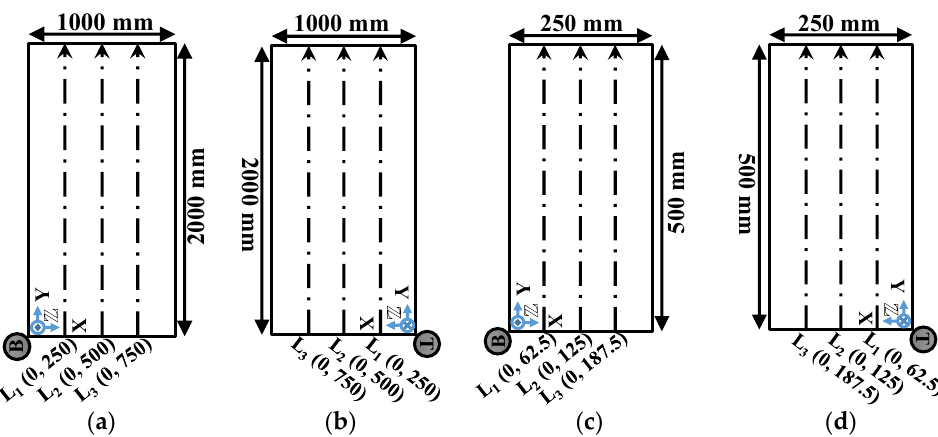
Figure 1. The measurement lines for acquiring the joint roughness coefficient (JRC) value for the fracture surfaces of the large ( a , b ) and medium ( c , d ) rock blocks. The viewing direction is toward the fracture surface, either bottom (B) or top (T) of the slab.